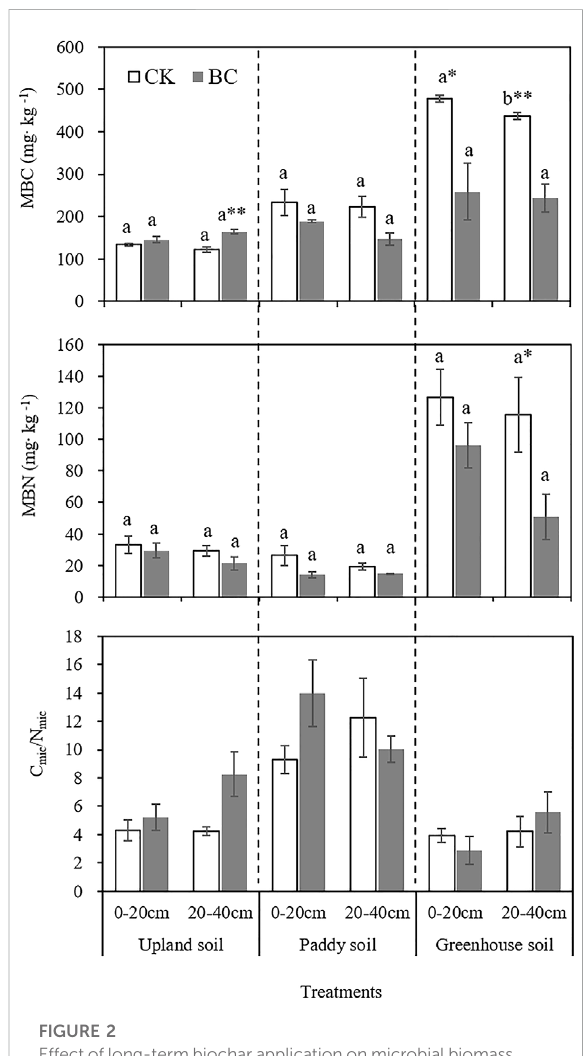
FIGURE 2 Effect of long-term biochar applicationon microbial biomass C and N (MBC and MBN). C mic /N mic refers to the ratio of MBC to MBN. Bars represent the standard error of the mean. Different lowercase letters indicate signi fi cant differences between 0 – 20 and 20 – 40 cm soil layer, the * and ** indicate signi fi cant differences between the control and biochar treatments within same soil depth at p < 0.05 and 0.01, based on an independent t